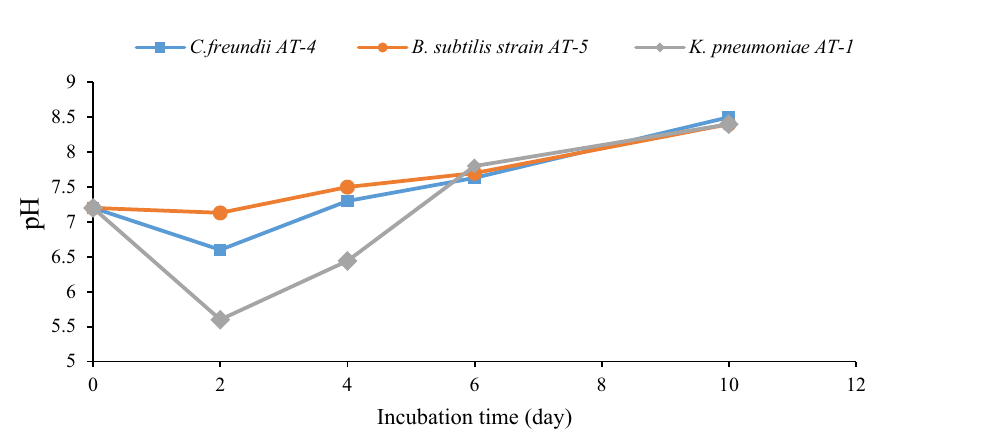
Figure 4. pH variations during RPCM effluent degradation (effluent + culture + mineral salt + glucose). Note . RPCM: Recycled paper and cardboard